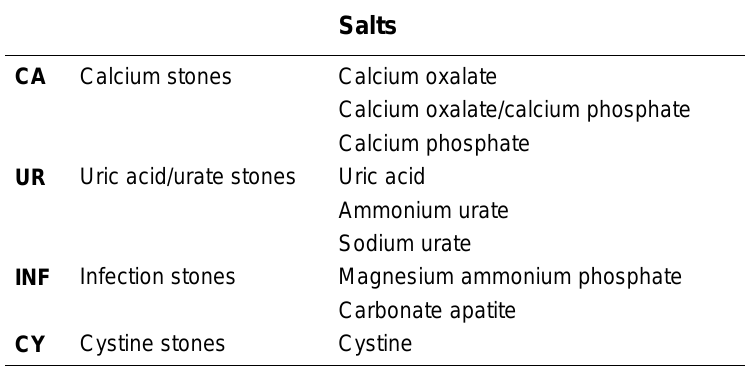
Subgrouping of Patients According to the Stone Composition